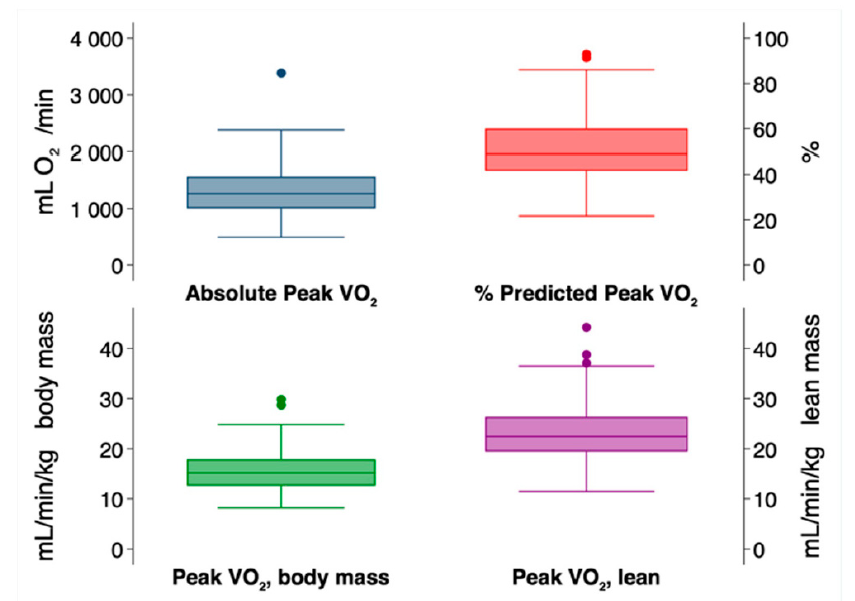
Figure 2. Distribution of Post-Transplant Peak VO 2 Indices. Box plots displaying the median, 1.5× interquartile range, and outliers for each VO 2 metric.